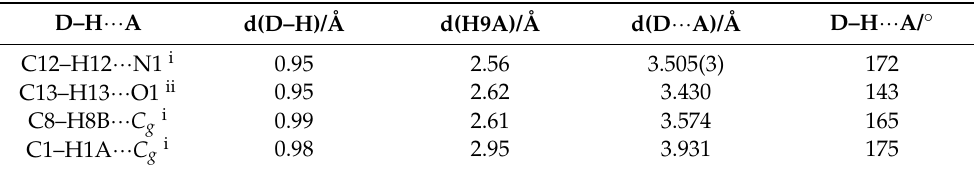
Table 2. Geometries of C–H ··· N, C–H ··· O, and C–H ··· π interactions (Å, ◦